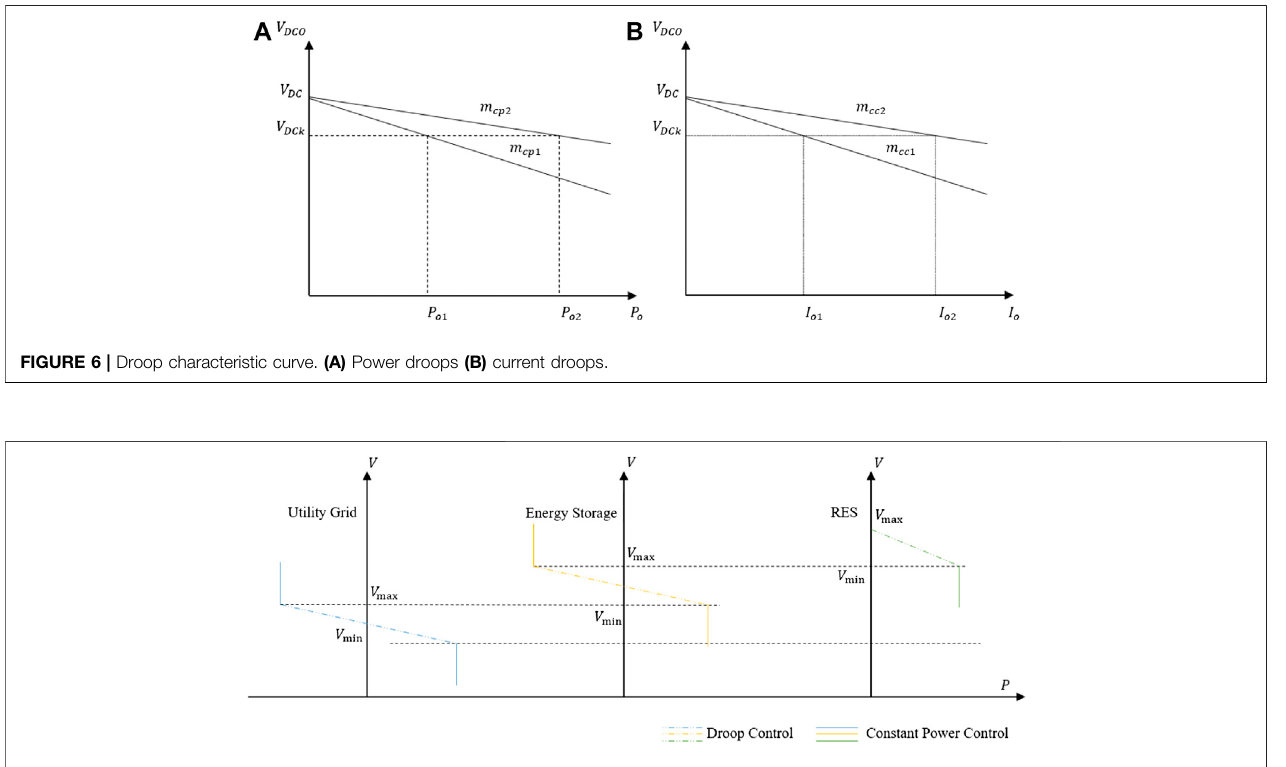
FIGURE 7 | Droop characteristics with different bus regulating